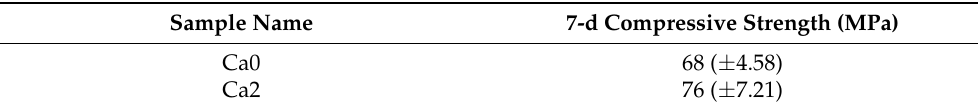
Table 3. The 7-d compressive strength of metakaolin-based geopolymer. The addition of 2% calcium hydroxide improved the mechanical property of